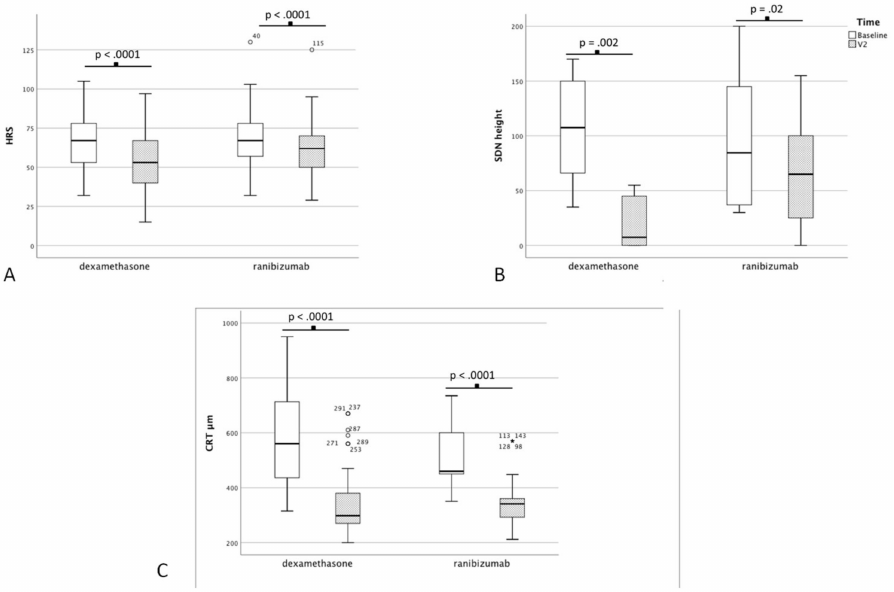
Figure 3. Box plot of: ( A ) hyper-reflective spots, ( B ) serous detachment of neuro-epithelium height, ( C ) central retinal